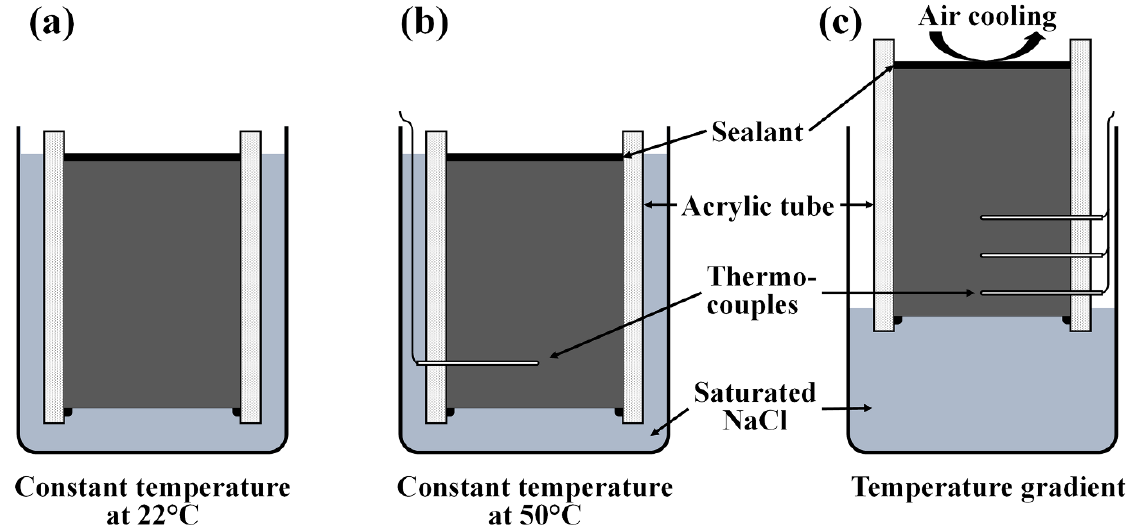
Figure 1. Chloride diffusion test setup at three different temperature conditions immersed in the NaCl solution, which are: ( a ) constant temperature of 22 °C, ( b ) constant 50 °C, and ( c ) temperature gradient condition. Thermocouples were positioned at depths of 10 mm, 30 mm, and 50 mm from the exposed surface. (Double-column fit).